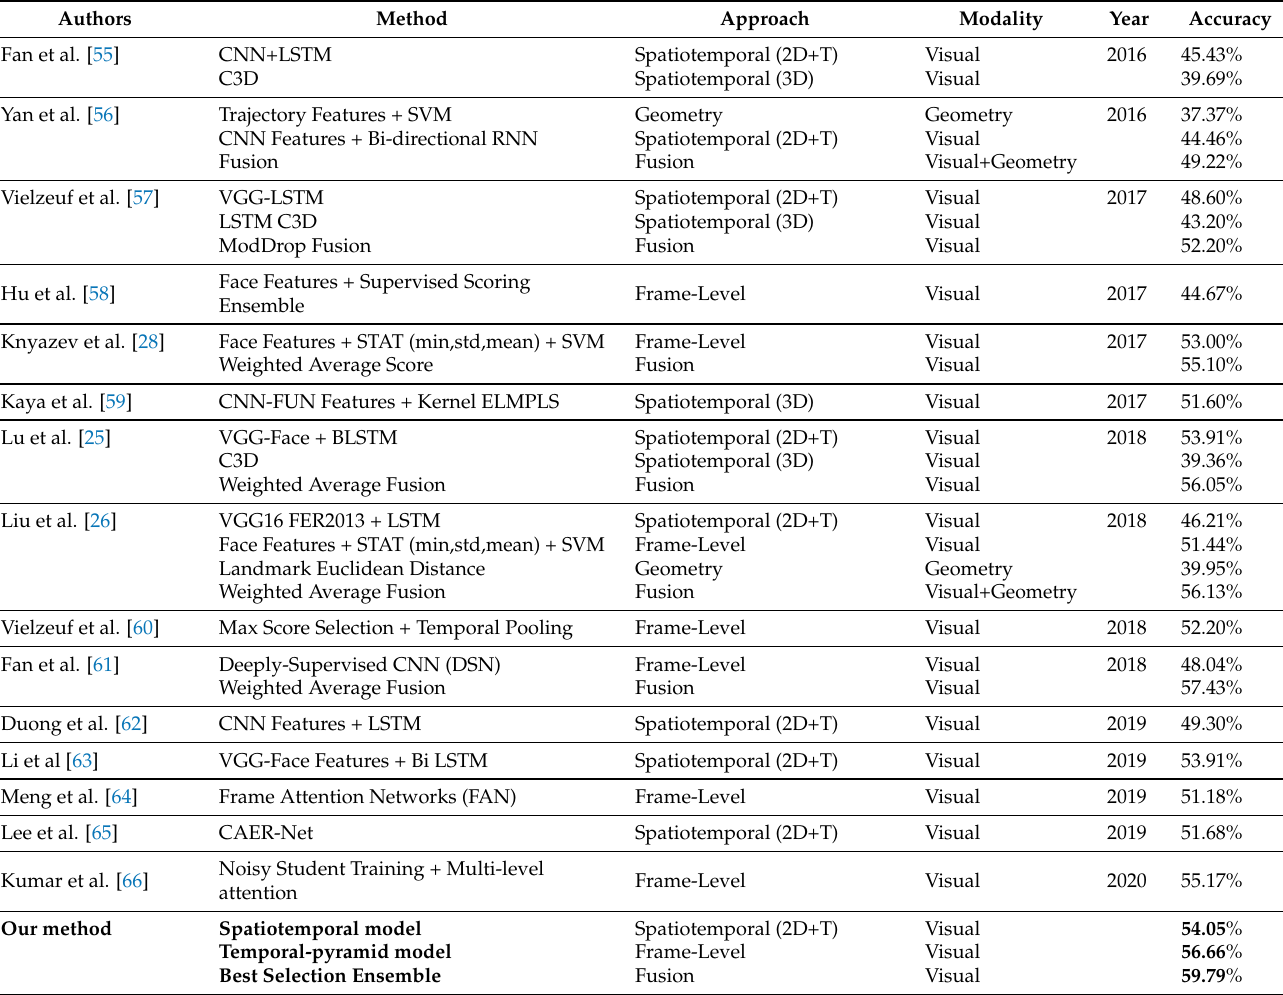
Table 6. Performance comparison with related studies on AFEW validation